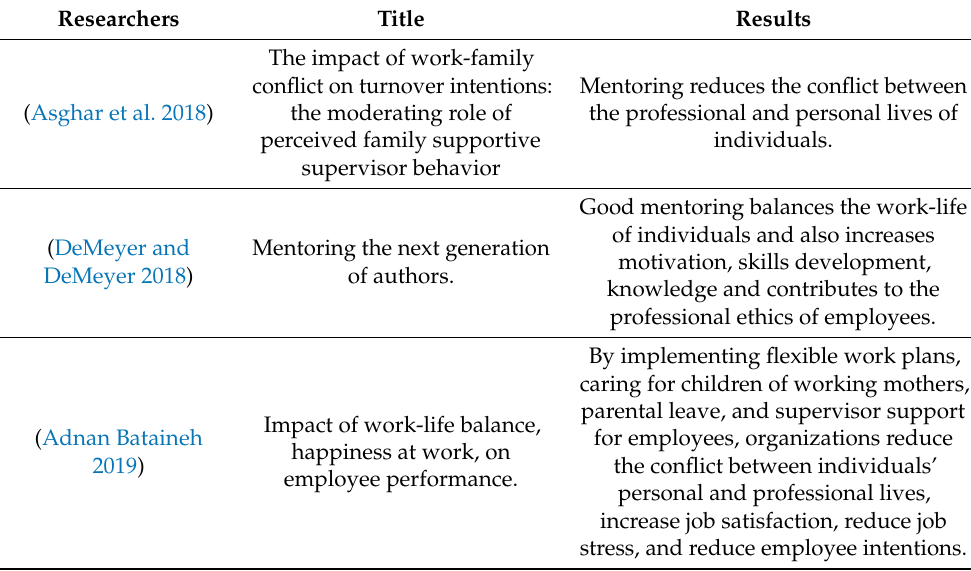
Table 1. Notable literature on mentoring and work-life